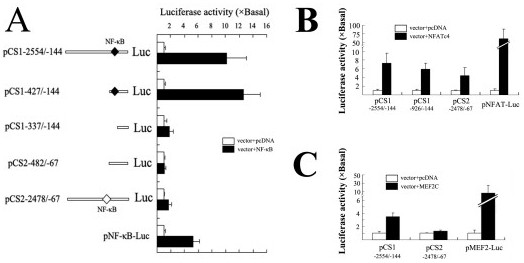
The activation of CS-1 and CS-2 promoters by different signalling molecules. A. Deleted promoter constructs of CS-1 and CS-2 were used in the NF-κB p50 cotransfection analysis. A schematic representation of these two promoters is shown. These vectors were cotransfected with pReceiver-NF-κB1. B. A range of different truncated promoter constructs (pCS1-2554/-144, pCS1-926/-144 and pCS2-2478/-67) were cotransfected with pcDNA-NFATc4. A consensus NFAT element in the region -1206 to -926 was removed in the pCS1-926/-144 vector. C. The two wild type calsarcin promoters were cotransfected with pReceiver-MEF2C. The pNF-κB-Luc, pNFAT-Luc and pMEF2-Luc vectors were used as controls. Values are expressed as ratios of the basal activity (resulting from cotransfection with an empty pcDNA3.1 vector) and represent the mean ± SD for two sets of independent experiments, each performed in triplicate. (Note: comparison of luciferase activity between different vectors is not valid.)